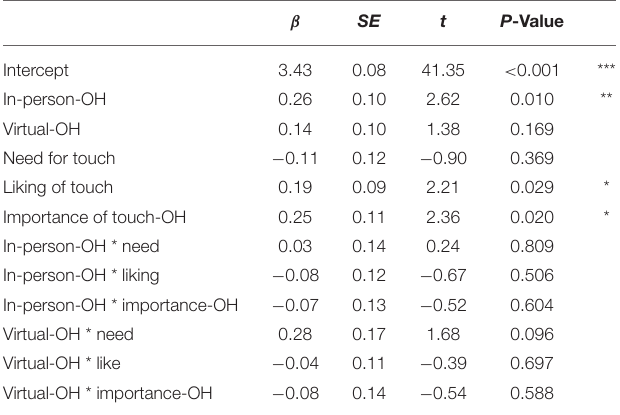
Table 2 ]. With increasing frequency of in-person contacts to non- household members, as well as a higher liking and importance of social touch in relationships to non-household members, the experienced closeness towards these members of the social network increased ( Figure 3 ). None of the interactions of the